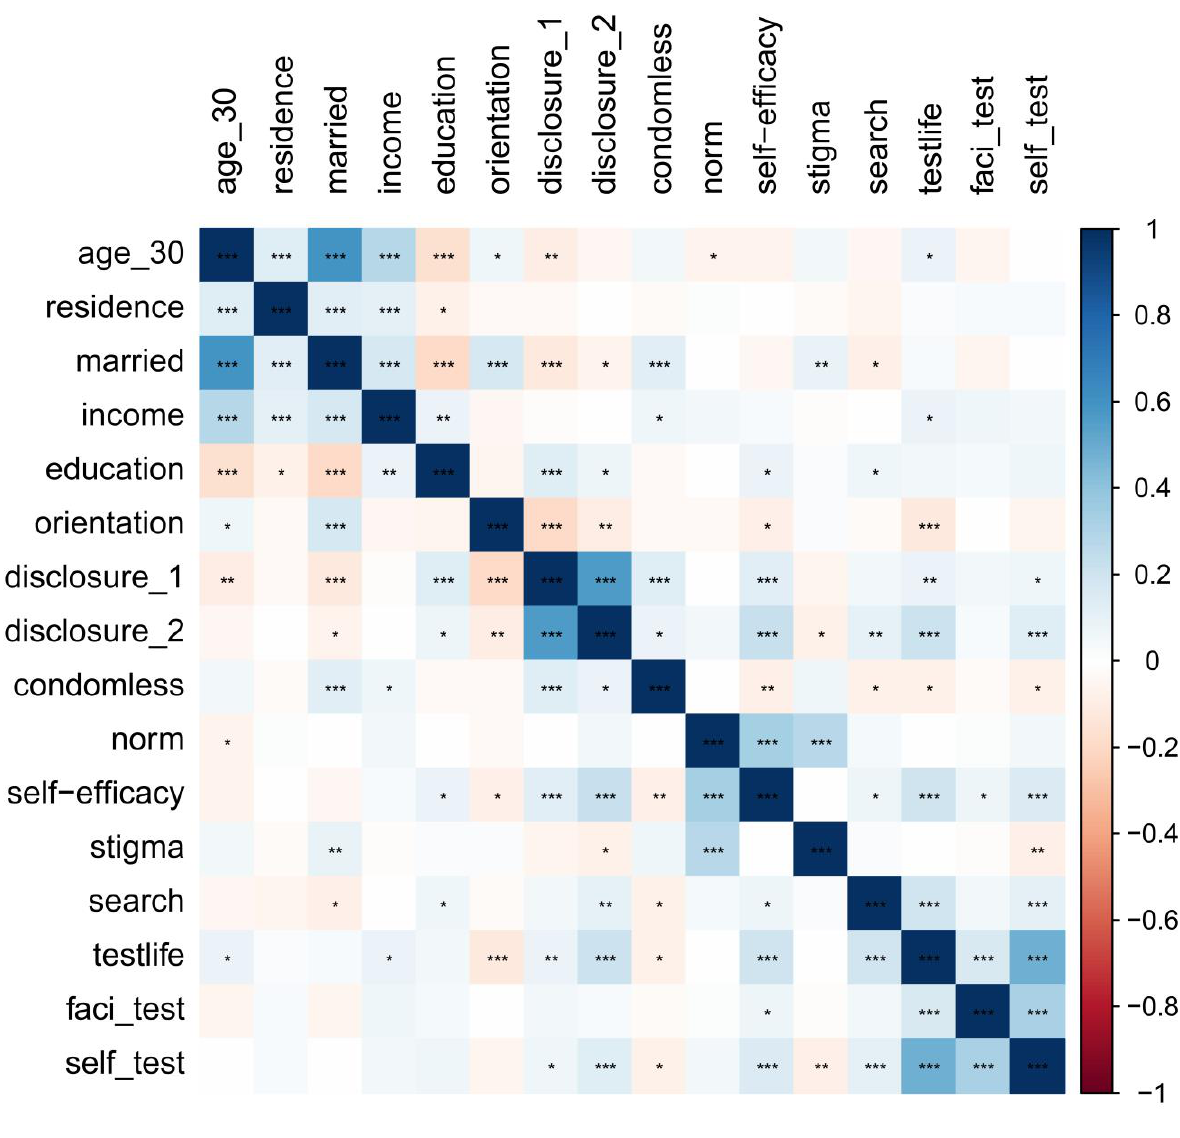
Figure 1. Correlation between demographic characteristics, sexual behaviours, social media use, and HIV testing uptake. Note. ***, p < 0.001; **, p < 0.01; *, p < 0.05.